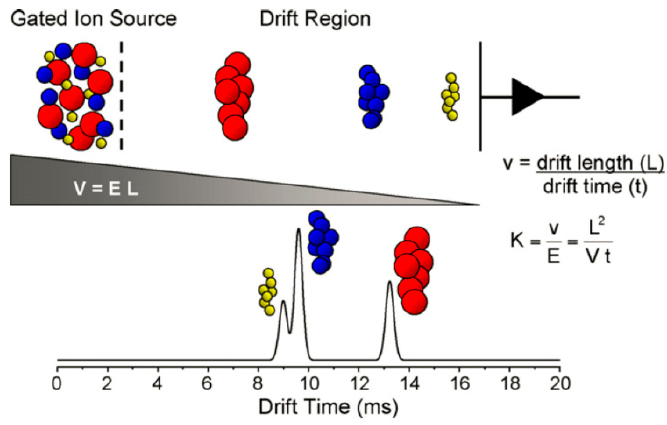
Figure 14. Principle of ion mobility spectroscopy. Adapted from [127], with permission from © 2007 Elsevier.